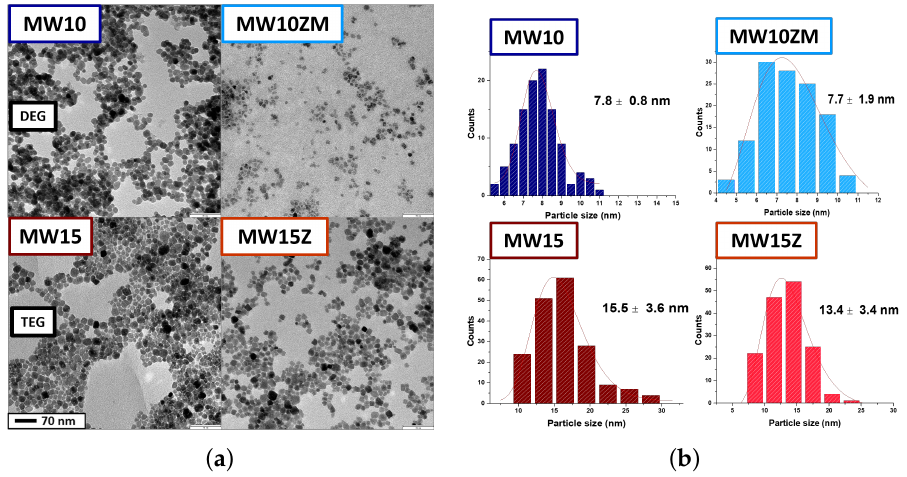
Figure 1. TEM images ( a ) and analysis ( b ) of samples MW10, MW10ZM, MW15, and MW15Z. Samples MW10 and MW10ZM have smaller dimensions than MW15 and MW15Z.